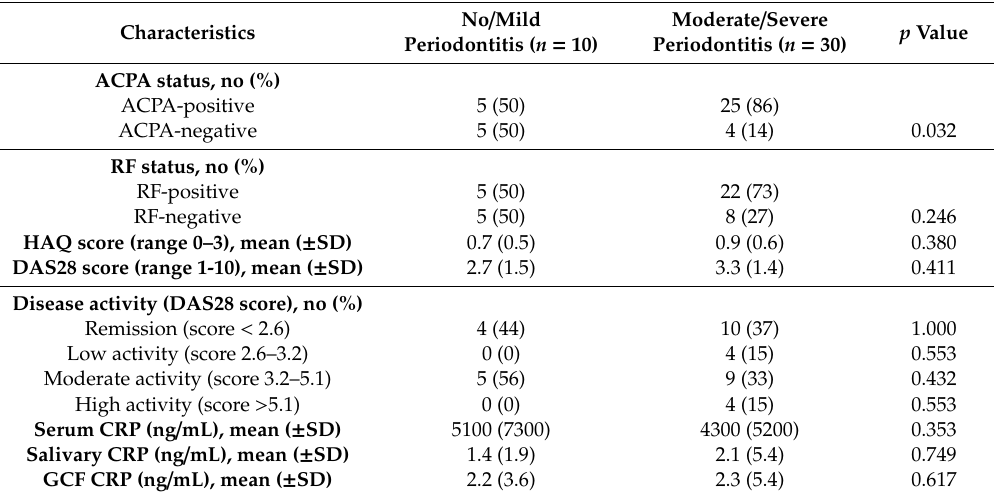
Table 2. Rheumatological and serological characteristics in relation to periodontal